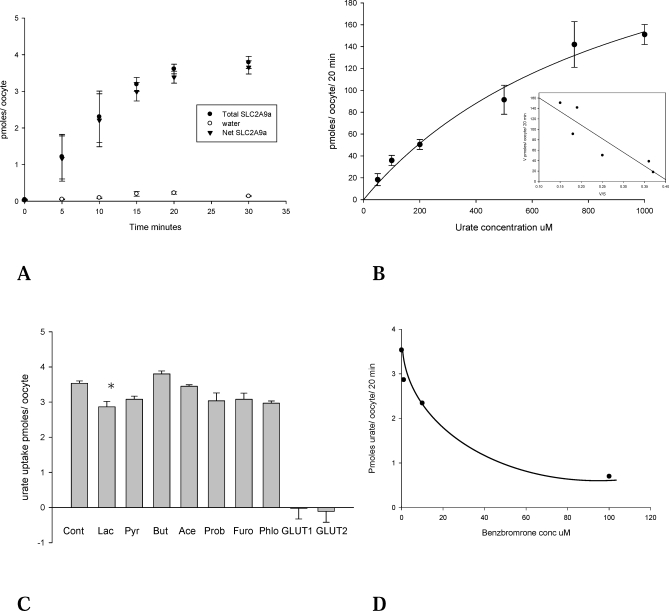
Characterisation of Urate Fluxes and Kinetics Mediated by Human SLC2A9 Expressed in Xenopus laevis Oocytes and the Effect of Short-Chain Fatty Acids and Uricosurics on Urate Transport(A) Time course of SLC2A9a-mediated urate uptake into Xenopus oocytes. Oocytes were injected with SLC2A9a cRNA or water and 4 d later incubated with 10 μM urate at 22 °C for the time periods indicated. Symbols represent the average uptake into ten oocytes per time point, with error bars representing the standard error of the mean (SEM). Solid circles show total uptake into oocytes expressing SLC2A9a cRNA, open circles urate uptake into water-injected oocytes, and inverted triangles the net uptake obtained by subtracting the water data from the total uptake for each time point.(B) Kinetics of human SLC2A9-mediated urate uptake in Xenopus oocytes. Symbols represent the mean data from six separate experiments each using ten oocytes per substrate concentration. Uptake was measured in oocytes injected with either SLC2A9a or SLC2A9b cRNA 4 d prior and corrected for uptake into water-injected oocytes. The curve was fitted by nonlinear regression analysis. The K
m = 981 μM and the V
max = 304 pmol/oocyte/20 min. Insert shows an Eadie-Hofstee plot of the same data.(C) Effect of uricosemics and short chain fatty acids on human SLC2A9a mediated urate uptake. Xenopus oocytes were injected with water or SLC2A9a cRNA and urate uptake measured 4 d later. Oocytes were incubated with 10 μM urate for 20 min, and bars represent net uptake determined by subtracting uptake into water-injected eggs from total uptake into SLC2A9a expressing oocytes, error bars are the SEM. Note: at no time was the urate uptake into the water-injected eggs more than 11% of the total uptake into SLC2A9-expressing oocytes. Compounds used were: no additional reagent (Cont), lactate 1 mM (Lac), pyruvate 1 mM (Pyr), butyrate 1 mM (But), acetate 1 mM (Ace), probenecid 1 mM (Prob), furosemide 100 μM (Furo), and phloretin 1 mM (Phlo). For comparison, a separate series of oocytes were injected with SLC2A1 (GLUT1) or SLC2A2 (GLUT2) cRNA and 100 μM urate uptake measured 4 d later using 30 min incubation times. Bars represent net uptake corrected for uptake into water-injected oocytes. *Significant inhibition at p ≤ 0.05.(D) Dose-dependent effect of benzbromarone on SLC2A9a-mediated urate uptake. Oocytes were injected with SLC2A9a cRNA or water and 4 d later were incubated with 10 μM urate for 20 min in the presence of 0, 1, 10, or 100 μM benzbromarone. Points represent the mean net uptake into ten oocytes corrected for uptake into water-injected eggs. Error bars were smaller than the data points.